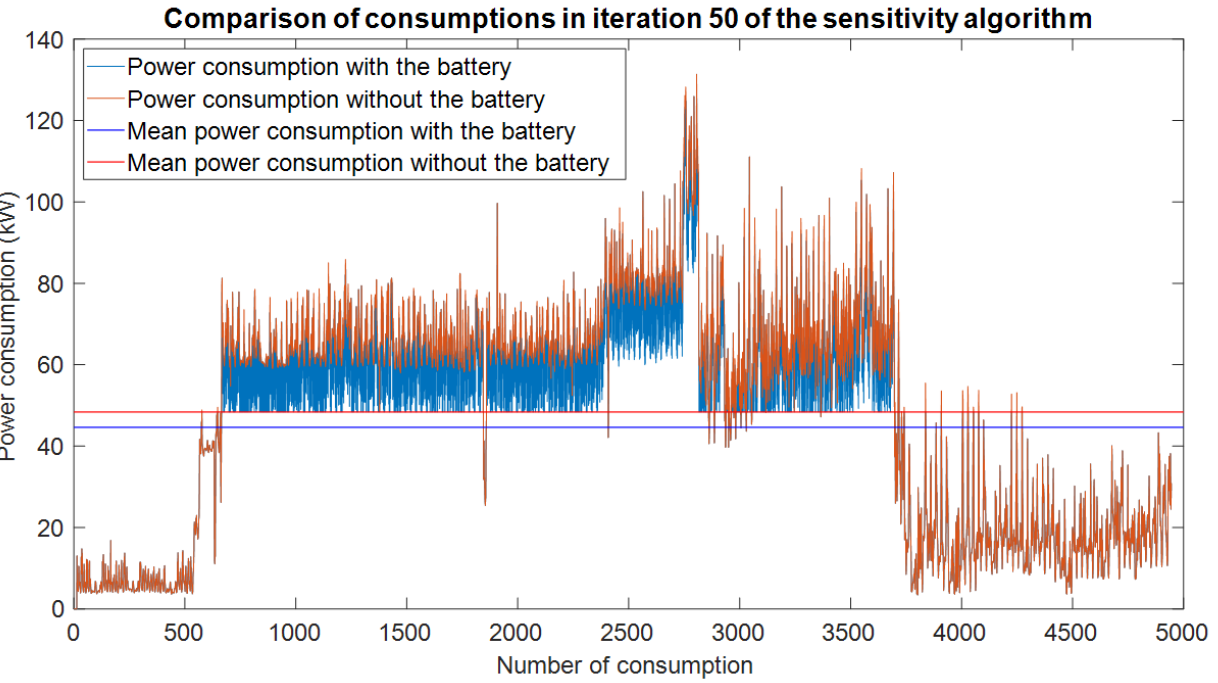
Figure 9. Power consumption (kW) comparison with and without the battery (iteration 30).